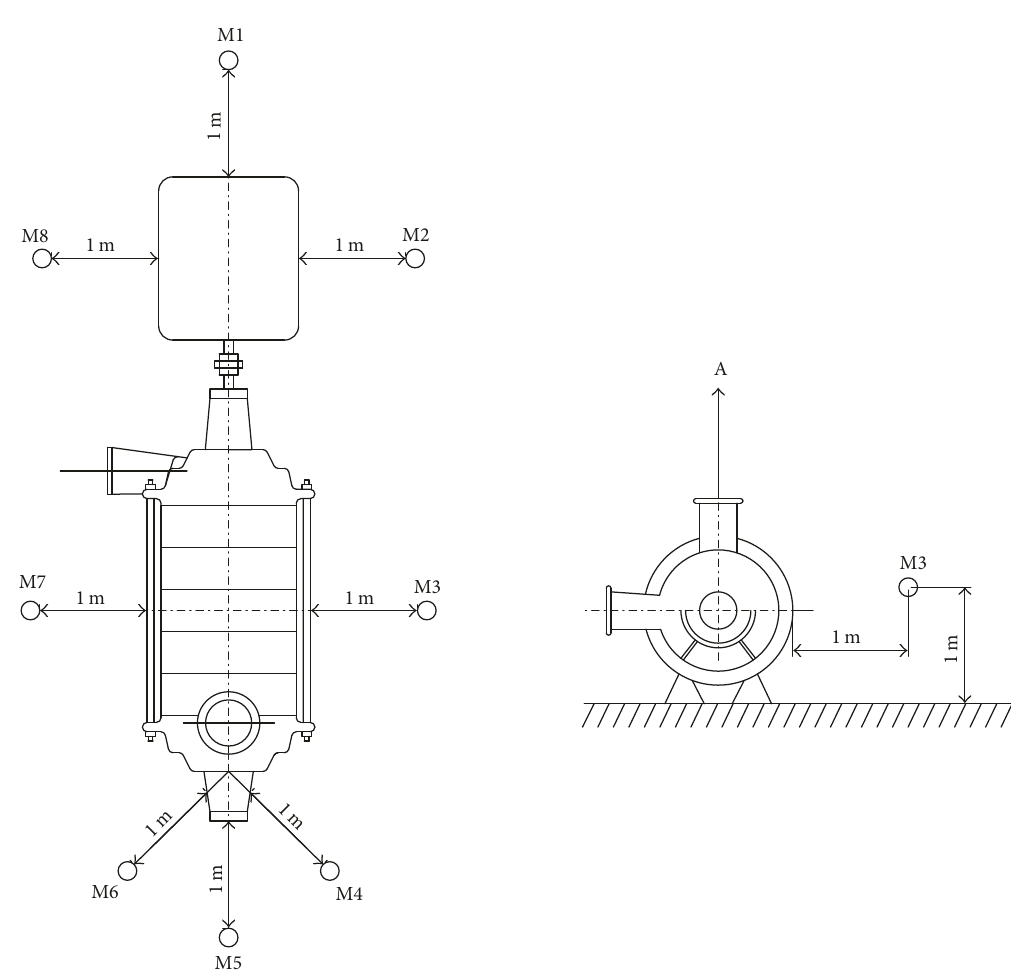
Figure 5: Location of noise monitoring